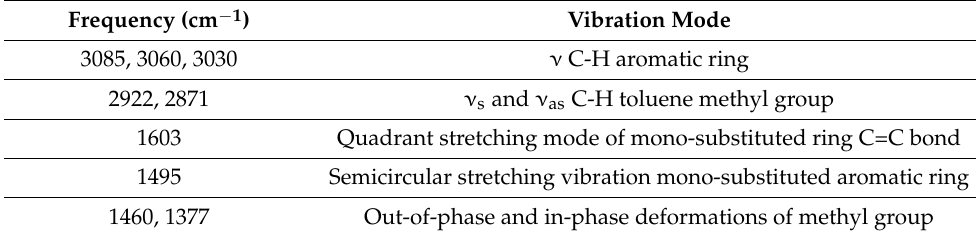
Table 2. IR Bands Formed after the Adsorption of Toluene on Mono-ICE.